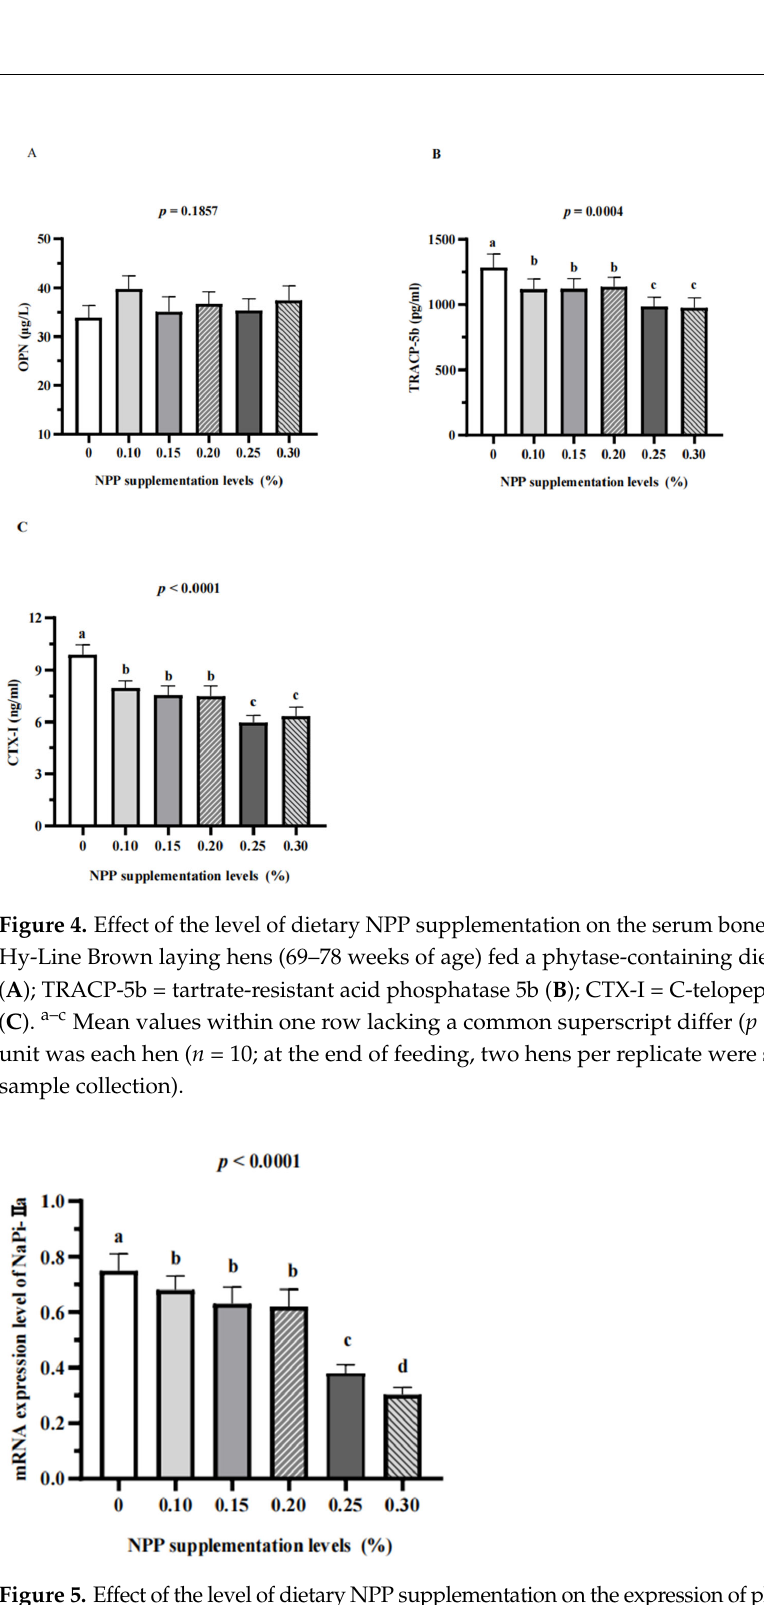
Figure 3. E ff ect of the level of dietary NPP supplementation on the serum bone formation markers of Hy-Line Brown laying hens (69–78 weeks of age) fed a phytase-containing diet. OPG = osteopro- tegerin ( A ); BAP = bone alkaline phosphatase ( B ); OCN = osteocalcin ( C ). a–c Mean values within one row lacking a common superscript di ff er ( p < 0.01). The statistical unit was each hen ( n = 10; at the end of feeding, two hens per replicate were selected randomly for sample collection).